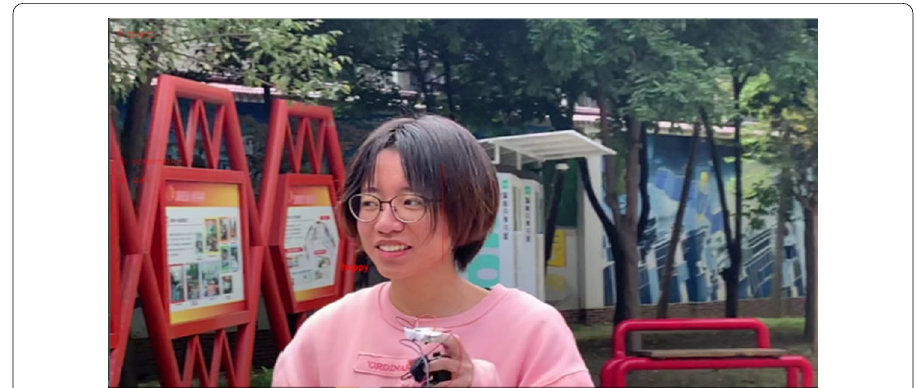
Fig. 8 Partial results of face detection and the expression recognition